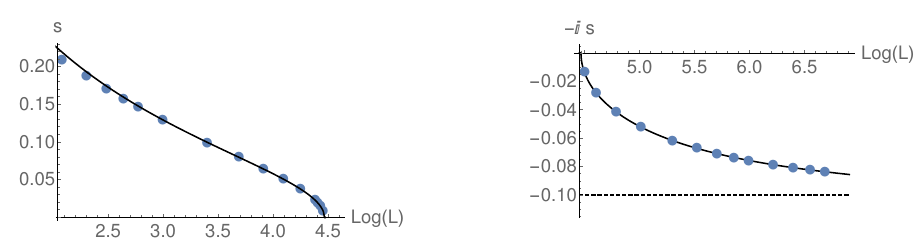
Figure 8. A plot of s ( L ) coming from the quantization condition (23) for the case with w = +1, m = S z = 0 with parameters (cid:13) = (cid:25) and k = 1 . The left panel shows that s ( L ) vanishes for 5 25 (cid:12)nite L . The right panel continues the (cid:13)ow above the threshold, where s becomes pure imaginary eventually reaching s = (cid:0) i (see eq. (34)), shown by the dashed line, in the L ! 1 limit. The 10 data points represent s obtained from the solution to the BA equations associated with the